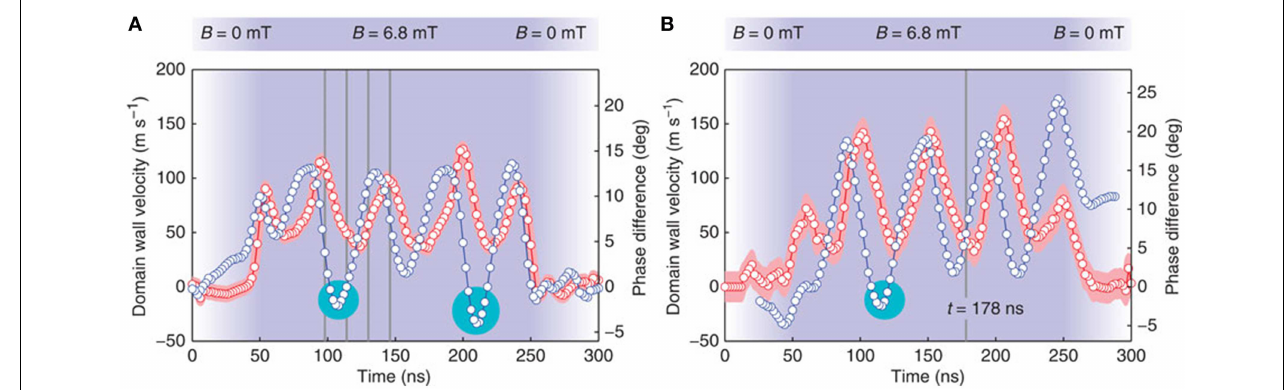
FIGURE 10 | From Bisig et al. [77]. Time dependence of domain wall velocity and phase shift for the DW motion (A) below and (B) above Walker breakdown in a ferromagnetic